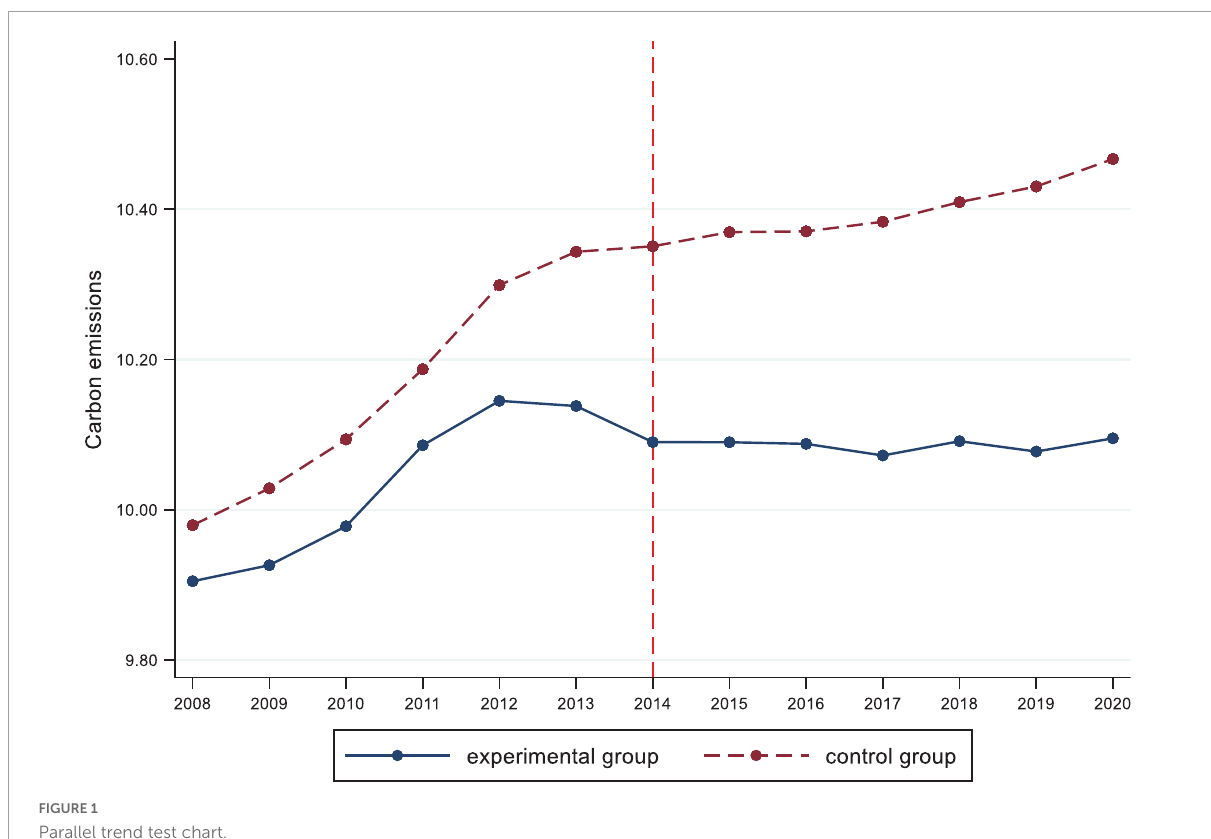
FIGURE1 Parallel trend test